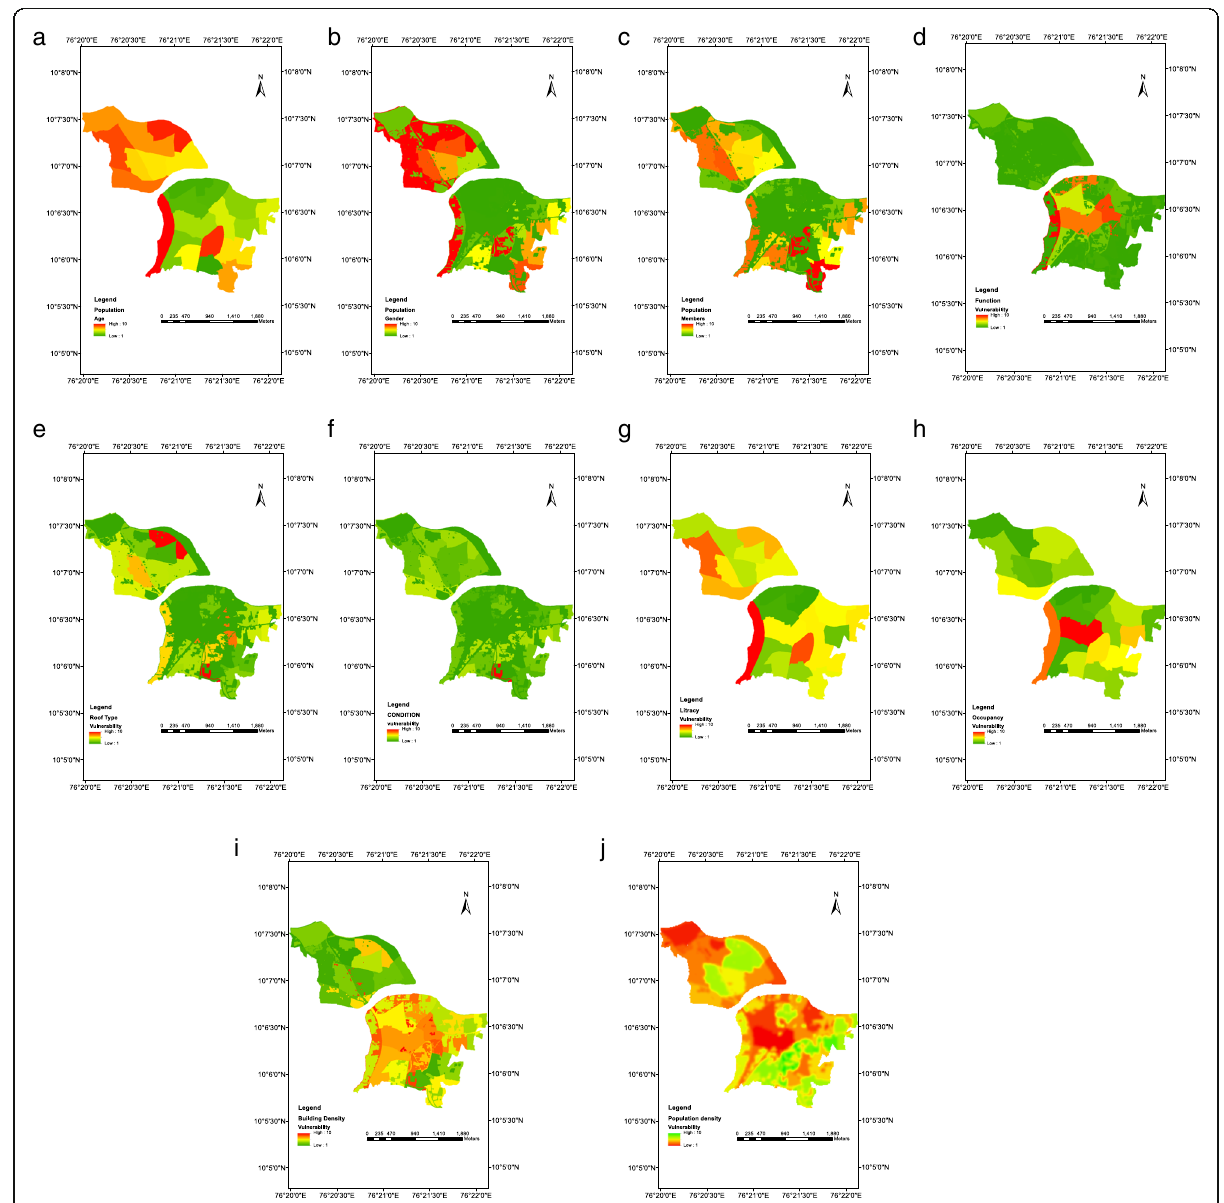
Fig. 7 Second level socio-economic vulnerability maps with respect to functions: a age b gender c Number of members per house d Building function e Roof type of building f Condition of the house g Literacy h Occupancy i Building density j Population